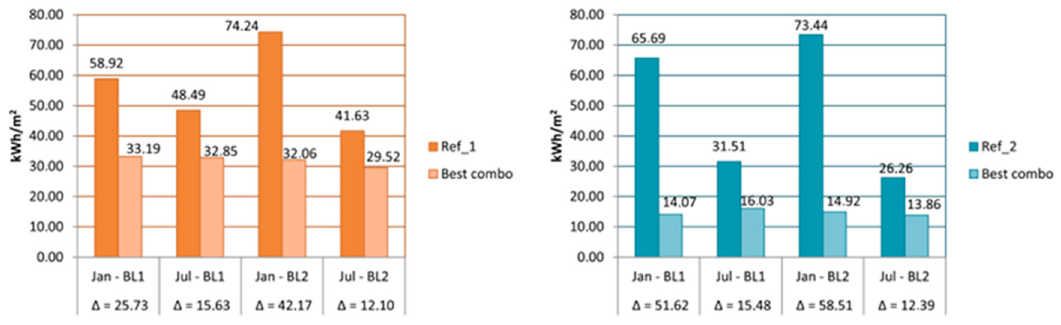
Figure 4. Monthly primary energy demand of Reference buildings 1 and 2.